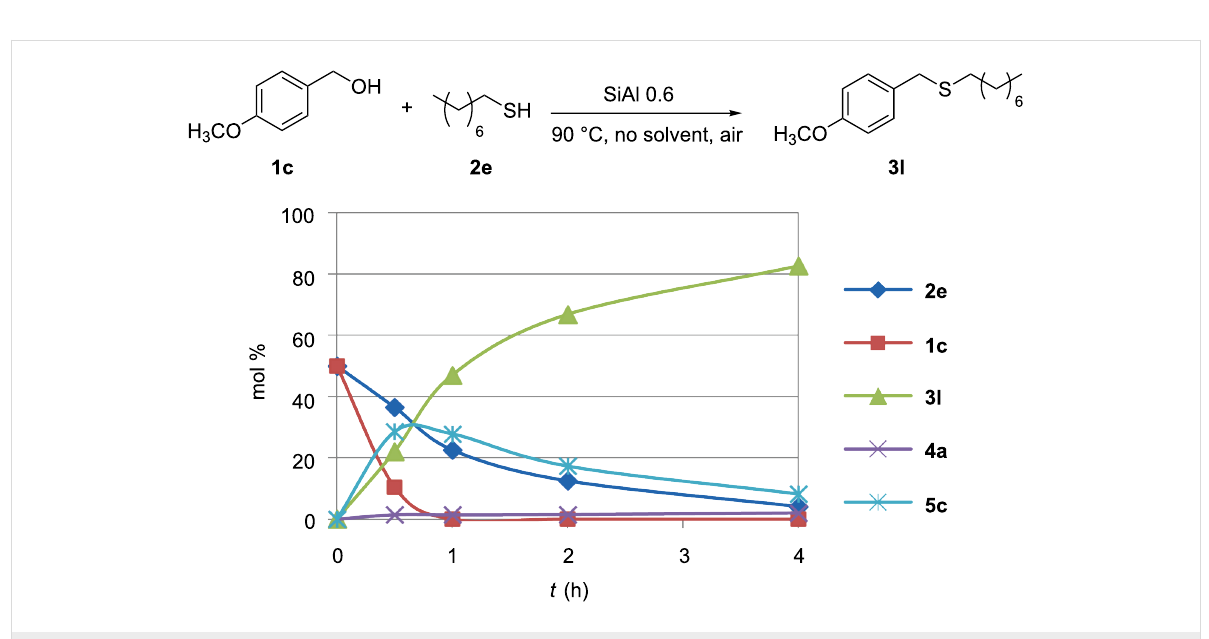
Figure 5: Product distribution during reaction of 1c and 2e